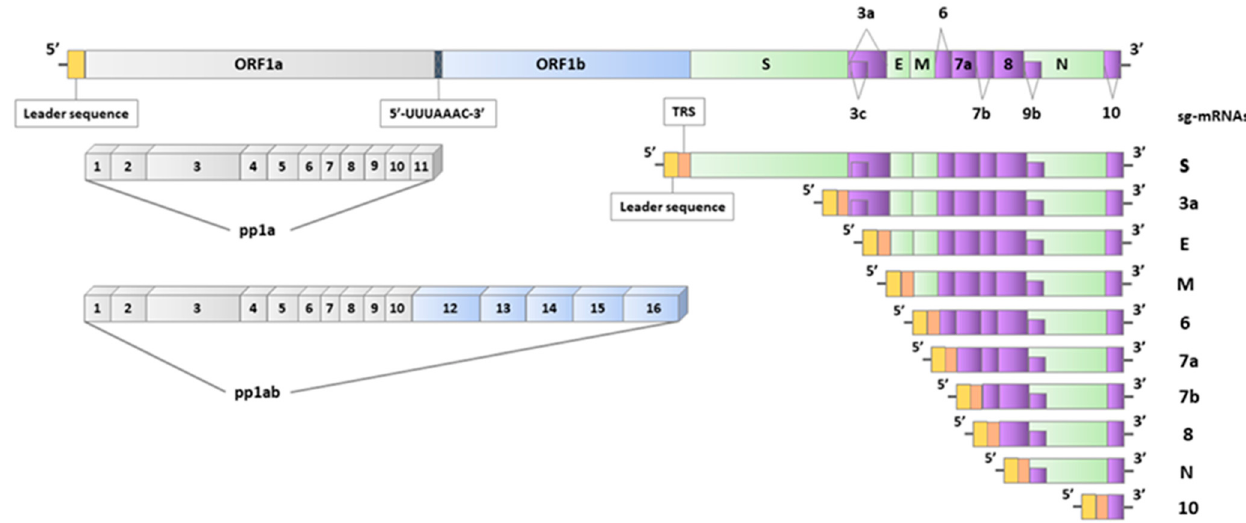
Figure 1. The structure of the SARS-CoV-2 genome and the ten nested sub-genomic mRNAs (sg- mRNAs). The open reading frames (ORFs) are indicated on the genome. The “slippery sequence” (5’-UUUAAAC-3’) is positioned between ORF1a and ORF1b. The polyproteins (pp1a and pp1ab) are expressed by ORF1a and ORF1b and, after post-translational processing, generate 16 non-structural proteins (nsp1-16). A leader sequence can be found at the 5’ of all positive-sense RNA molecules. The transcription regulatory sequences (TRS) are located right after the leader sequence in sg- mRNAs.